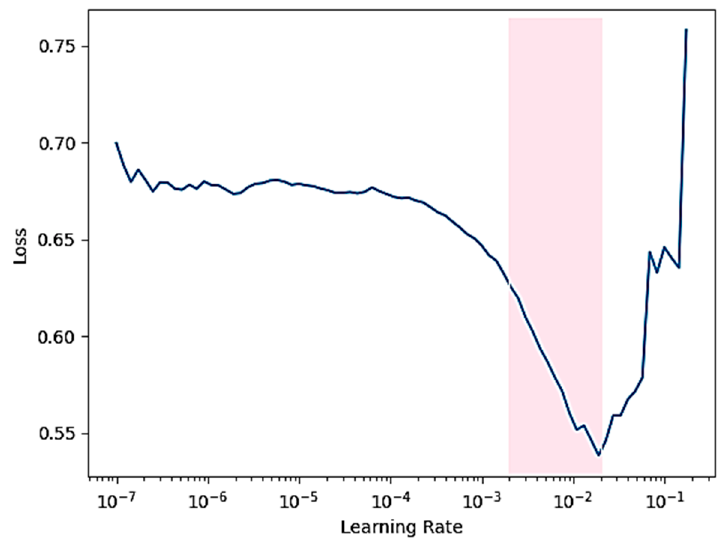
Figure 6. Learning rate chart. Pink rectangle indicates an area of optimal choices. In our case the ~7 × 10 − 2 learning rate was used.